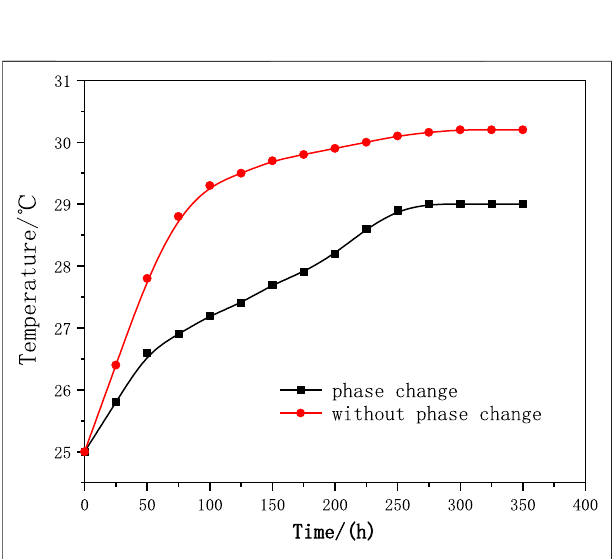
FIGURE 13 | Temperature change curves of internal east wall of the building model with and without phase change.